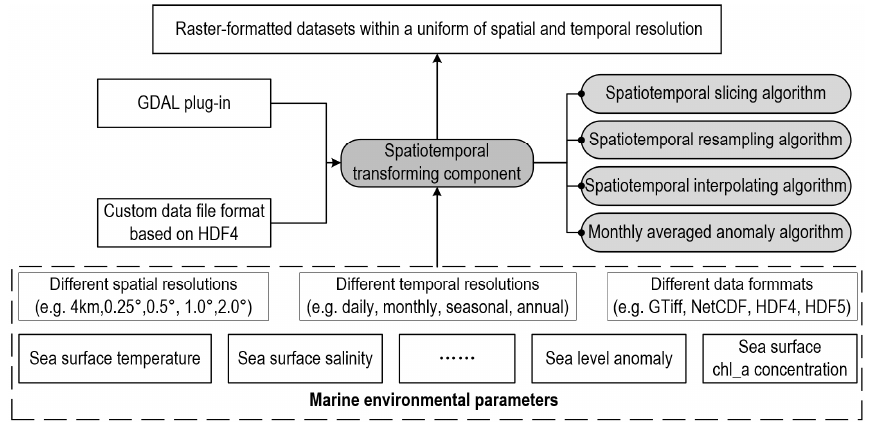
Figure 3. Workflow of raster-formatted dataset pretreatment module.